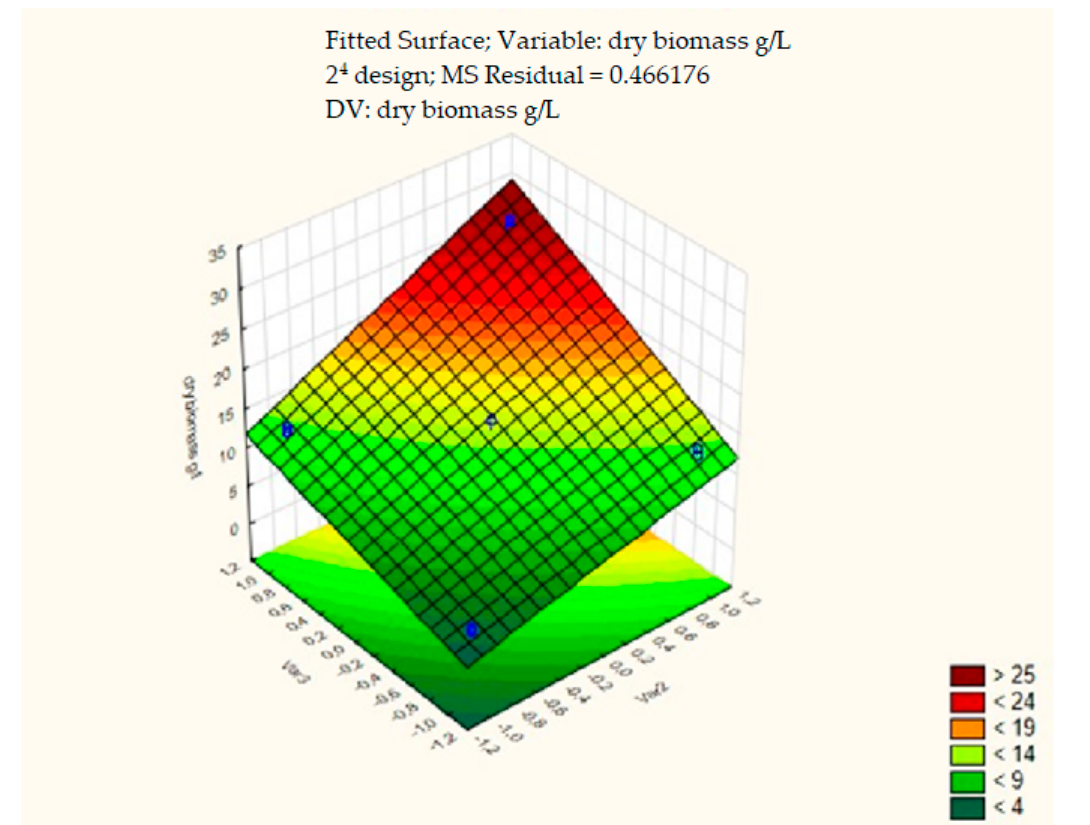
Figure 3. Response surface. The yield of F. velutipes biomass depending on the concentrations of soybean oil (Var 2) and soybean meal (Var 3).